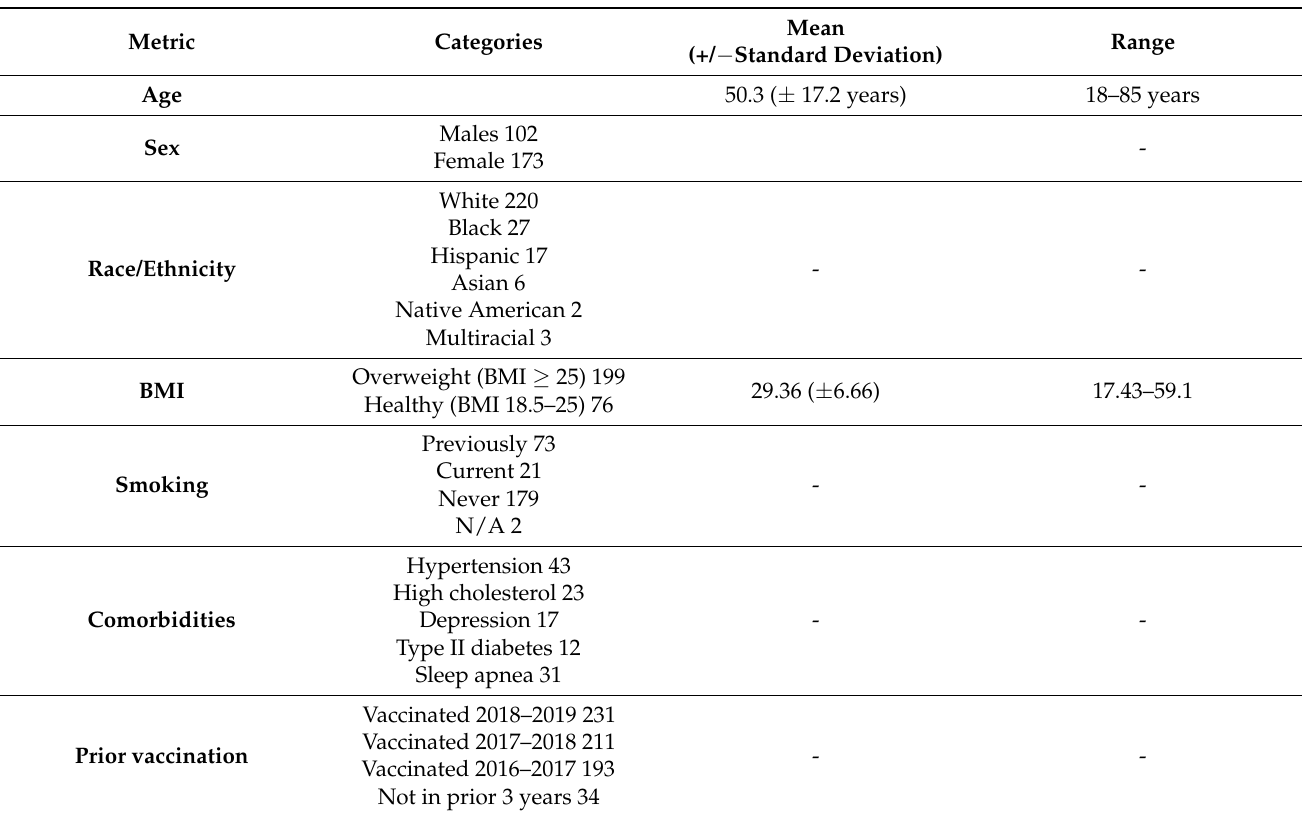
Table 1. Demographic and health metrics of study participants. A total of 275 participants in the included in the